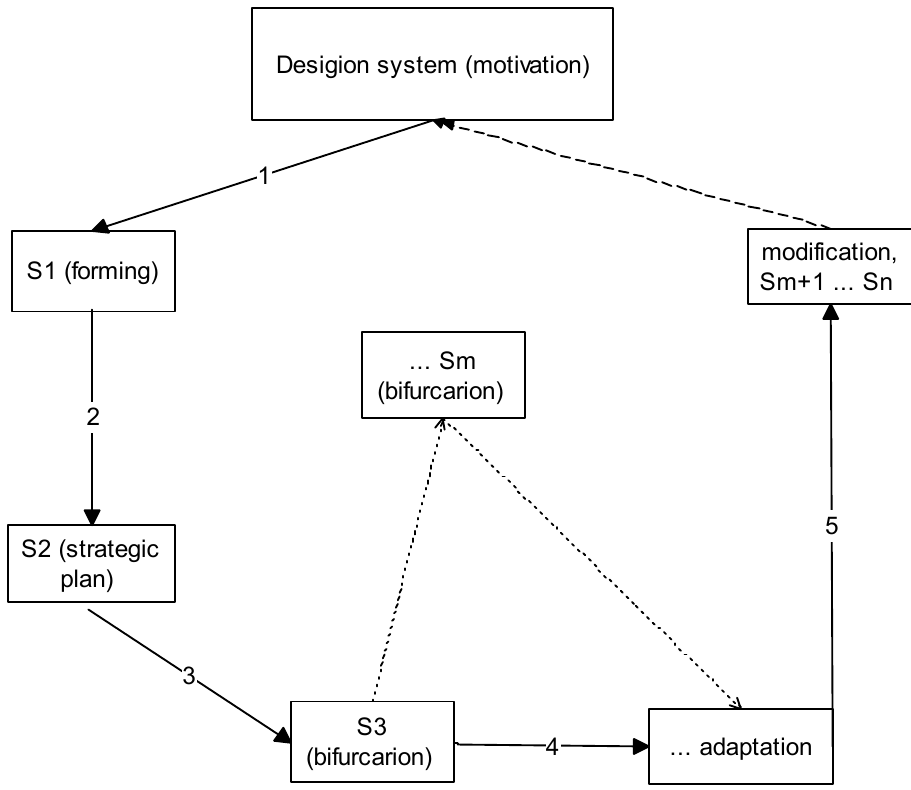
Figure 1. Scheme of strategic development and adaptation of the enterprise to changes in the business environment (Bifurcation-restructuring). Where: S1—the initial state of the industrial holding as an open stationary system; S2, S3, Sn, Sm—the state of the holding after the application of adaptation mechanisms and tools; MDMS—is a management decision making system.